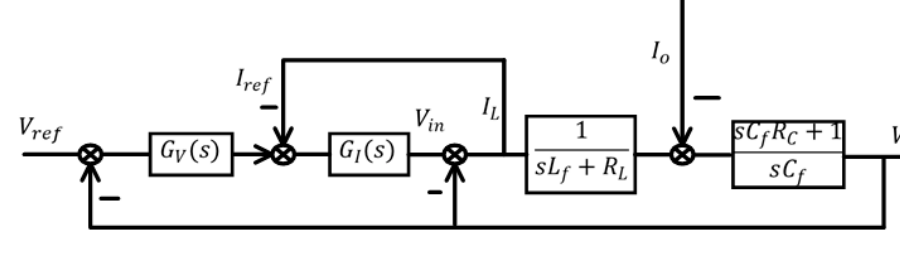
Figure 3. The transfer function block of the VCM system.